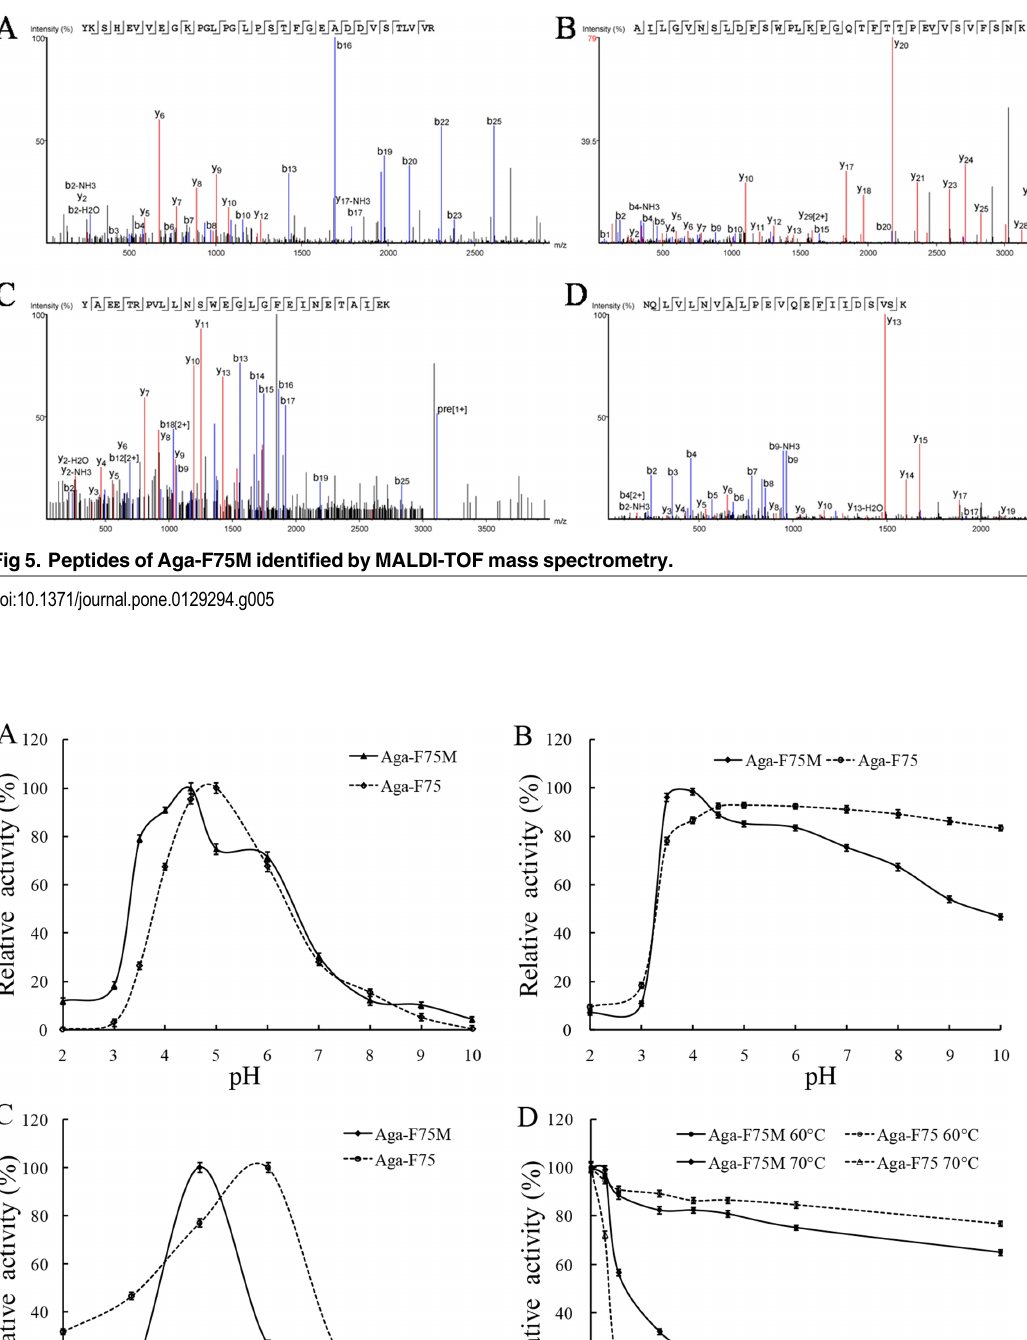
PLOS ONE | DOI:10.1371/journal.pone.0129294 June 8,